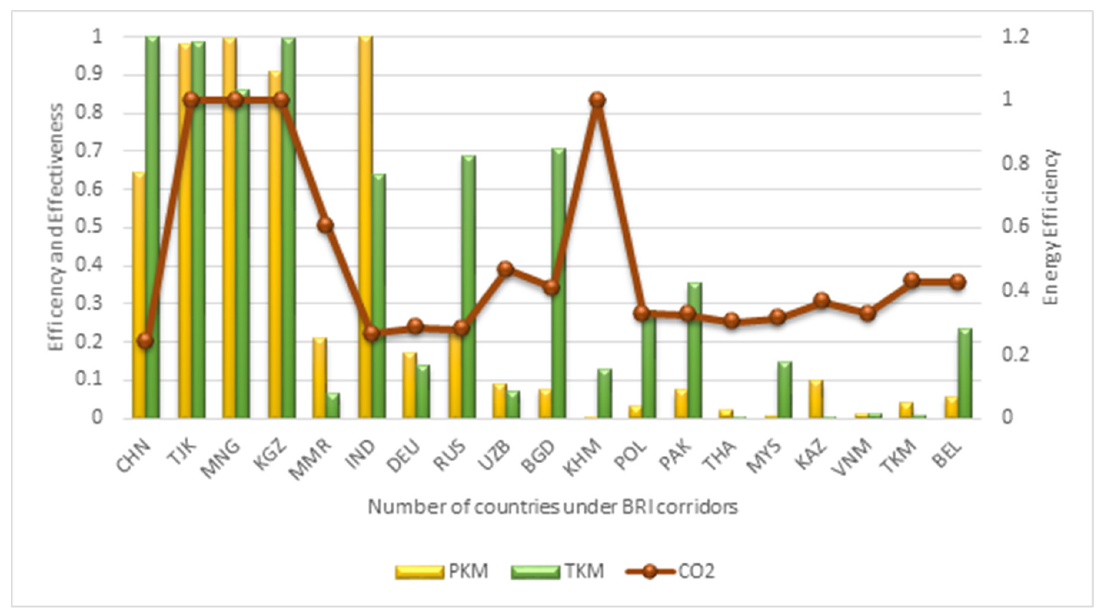
Figure 3. Energy efficiency concerning PKM (Passengers-Kilometers) and TKM (Tons-Kilometers). Figure 3. Energy e ffi ciency concerning PKM (Passengers-Kilometers) and TKM